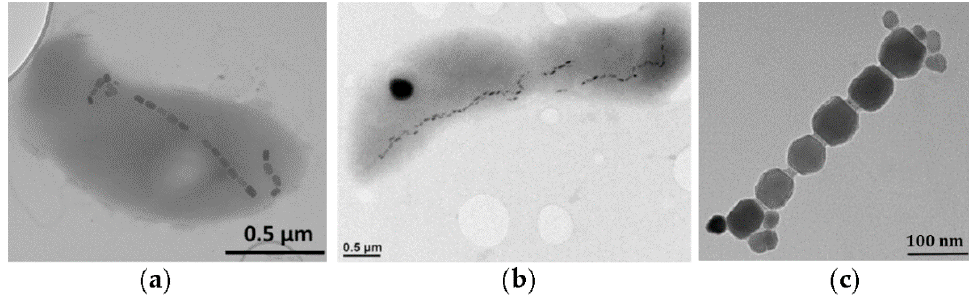
Figure 3. Transmission electron microscopy (TEM) images of magnetotactic bacteria with 1D chains of magnetosome nanoparticles of different morphologies. ( a ) Magnetovibrio blakemorei strain MV-1 where elongated prismatic nanocrystals can be found, ( b ) Desulfovibrio magneticus strain RS-1 which produces bullet-shaped nanoparticles, and ( c ) TEM images of magnetosome chain from a lysed cell of Magnetospirillum magneticum , strain AMB-1. Each cuboctahedral magnetite nanocrystal is surrounded by the phospholipid magnetosome membrane, which often remains stable even after cell lysis. Adapted from [17], Copyright 2013, with permission from Elsevier.